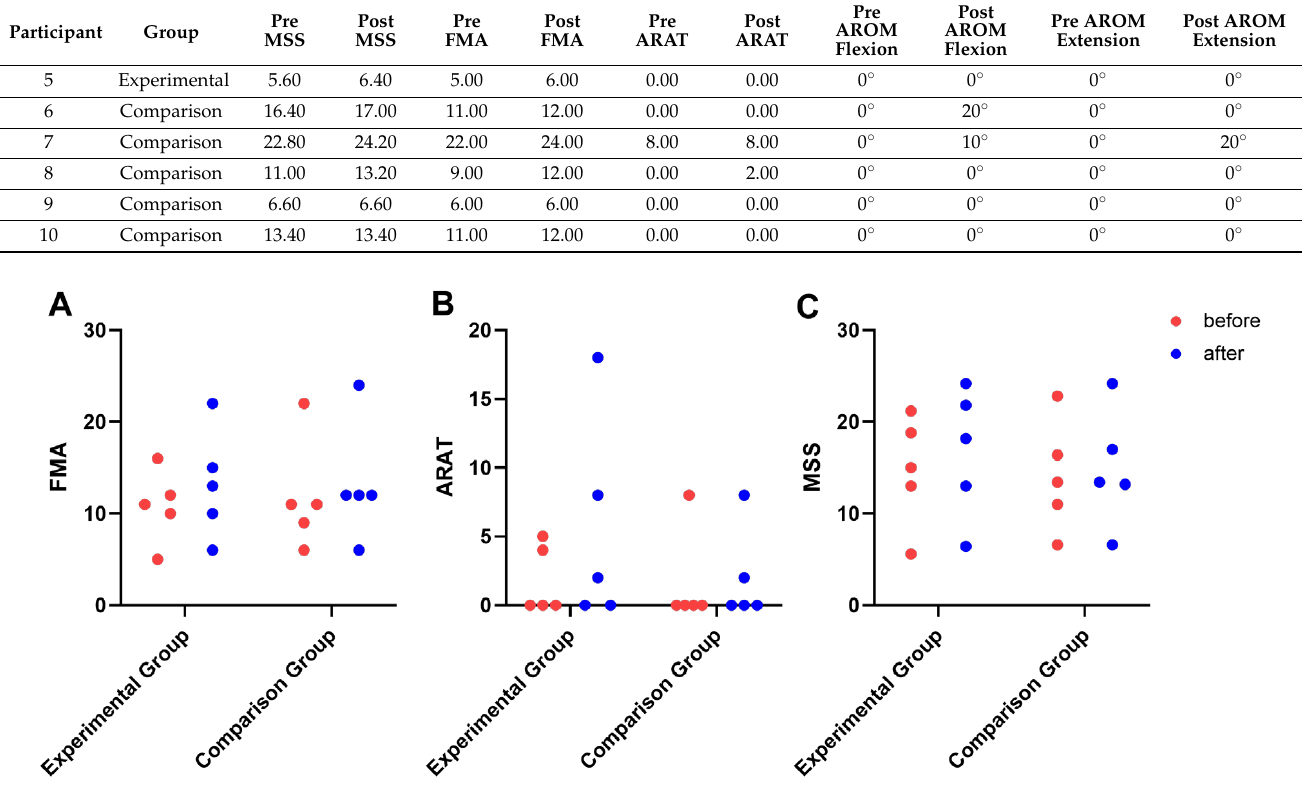
Figure 3. Behavioural Outcomes in Experimental group and Comparison group. ( A ) For FMA; ( B ) for ARAT; ( C ) for MSS. Table 4. FA for fibres across corpus